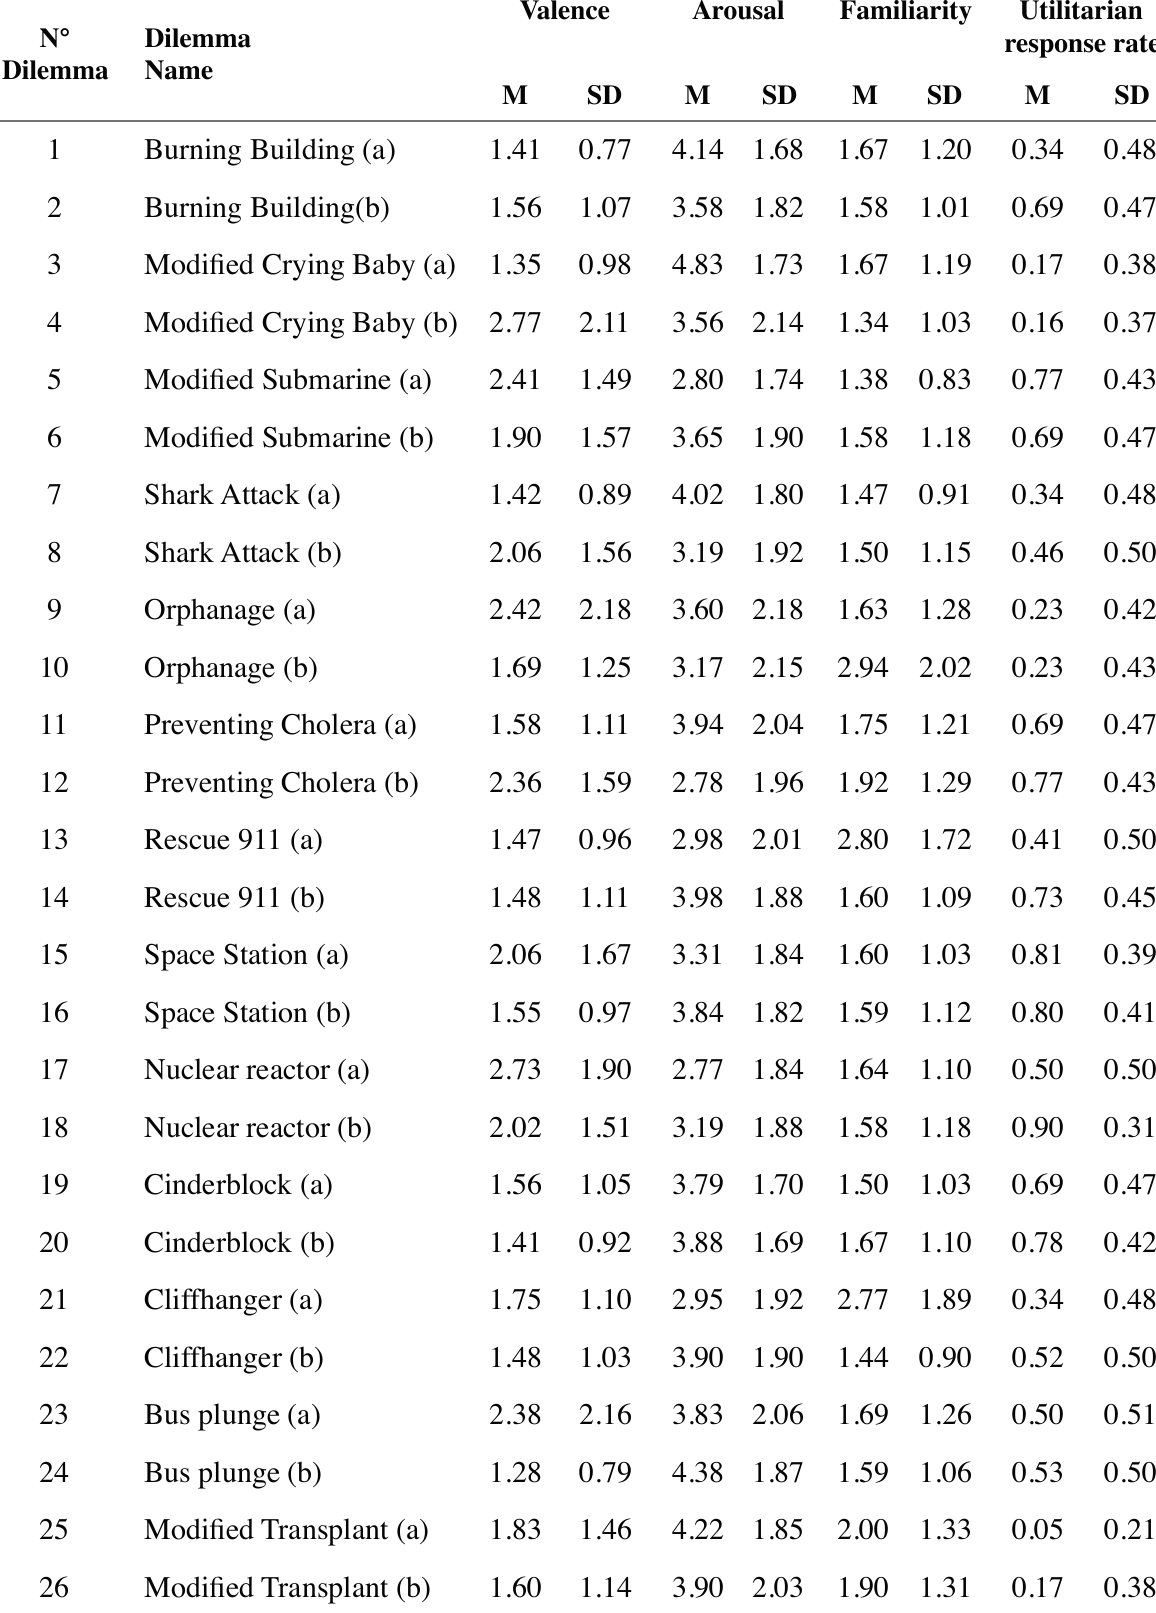
Table 3SI. Normative data for arousal, valence, familiarity ratings and utilitarian choices for the Italian 4CONFiDe dilemma